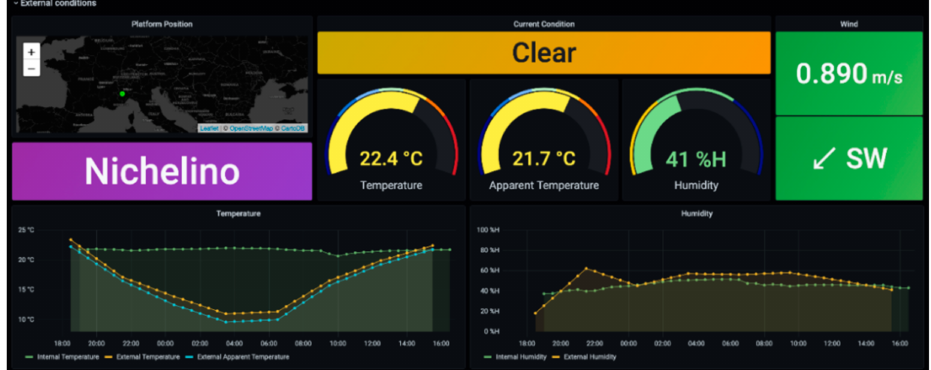
Figure 11. Sample view of the third dashboard section: external conditions.